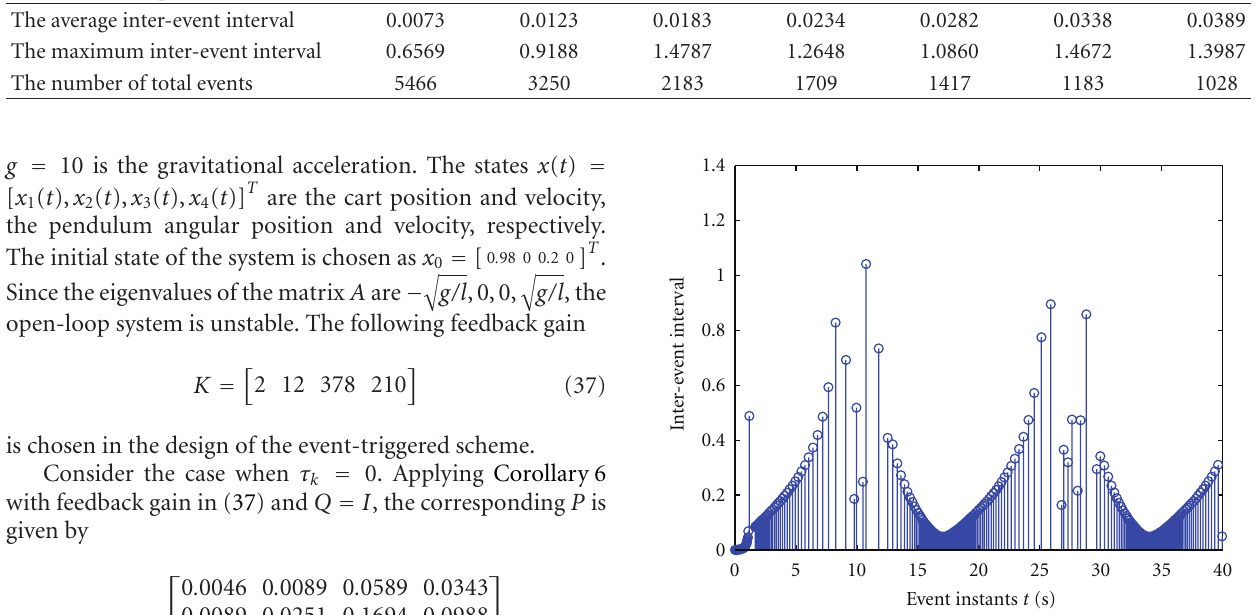
Figure 2: The event instants and inter-event intervals with event triggering condition in